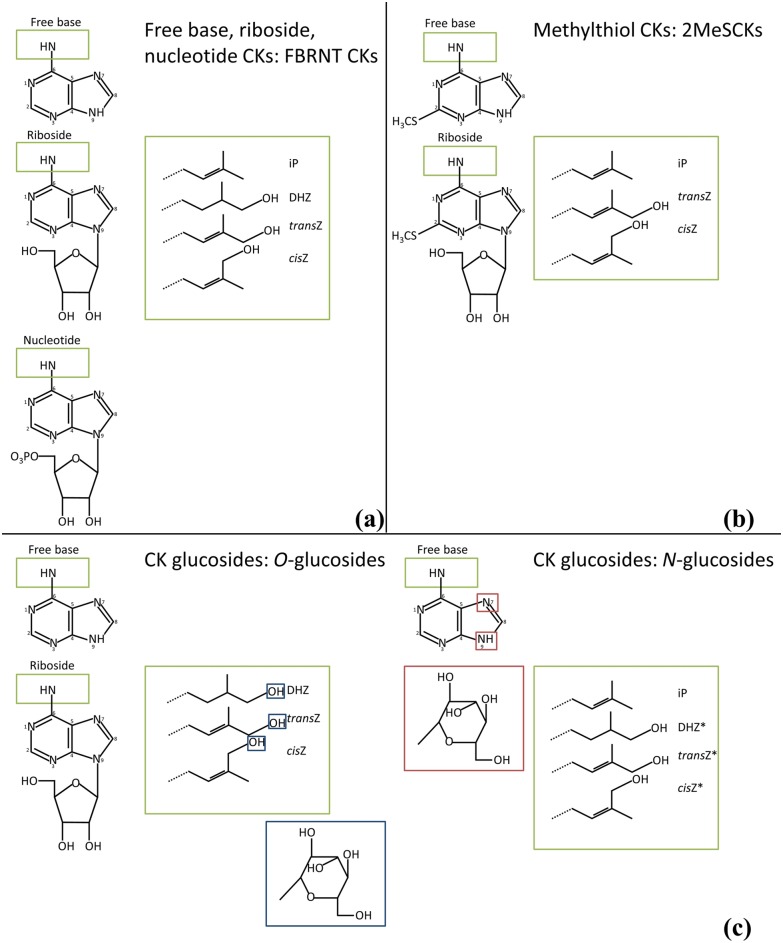
Representative CK structures for analytes detected/scanned for, in the Zea mays- U. maydis cob assay time course.(a) Free base, riboside, nucleotide CKs (b) Methylthiol CKs (c) CK glucosides including O-glucosides (left) and N-glucosides (right). Green boxes indicate addition of side chains; large green boxes show the different side chains. Blue boxes indicate the structure of glucose and location of glucosylation for O-glucosides. Red boxes indicate the structure of glucose and location of glucosylation for N-glucosides. Adapted from: Esberg et al. [70], Sakakibara [34], Frébort et al. [12]. *The 7G form of these analytes was not scanned for.